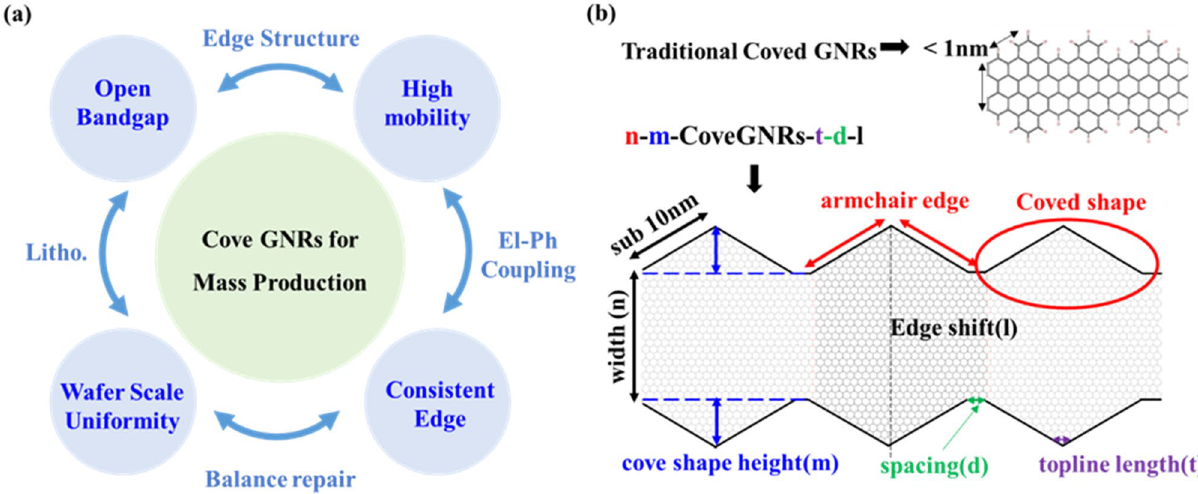
Figure 1. ( a ) Designed structure of CoveGNRs to solve the main issue in the mass production of GNRs. ( b ) Dimension scale of width and edge structure in traditional CoveGNRs is less than 1 nm. Dimension scale of